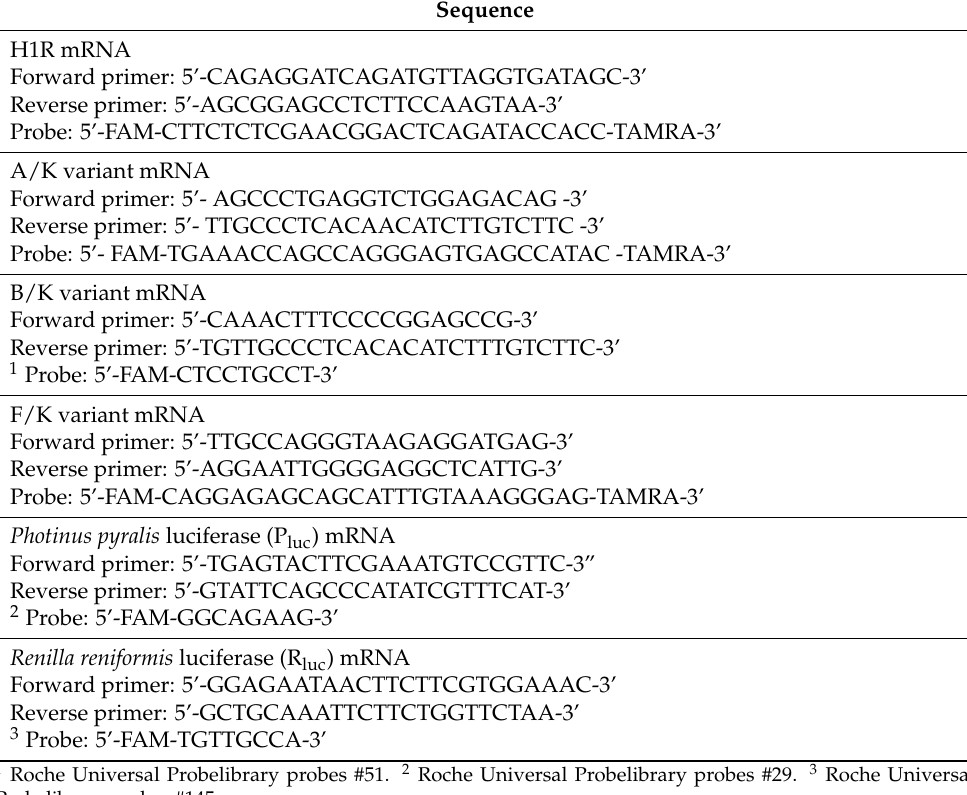
Table 1. Oligonucleotide primers and probes used for real-time quantitative RT-PCR. Sequence